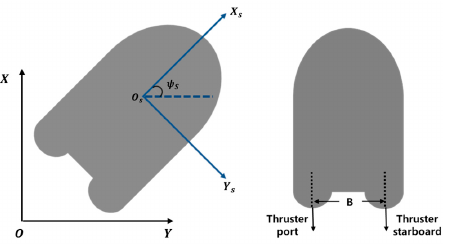
Figure 3. Conceptual diagram and coordinate system of USV